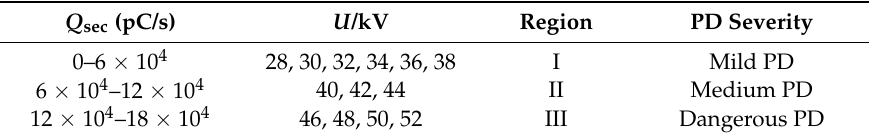
Figure 6. Three PD parameters over the applied voltage. Table 2. Division of PD severity.